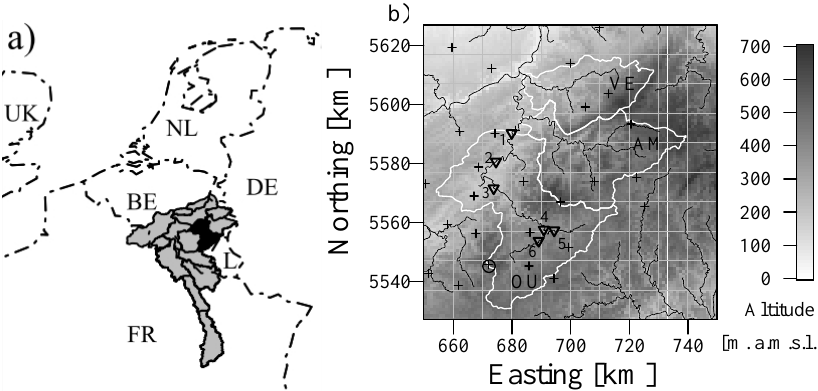
Fig. 1. (a) The Meuse River basin upstream of Sint Pieter, the entrance point into the Netherlands, and its 15 sub-catchments (grey polygons) including the Upper Ourthe (black polygon). (b) Topographic map of the Upper Ourthe (OU, white line) including the river network (black lines), rain gauges (plusses), six river gauges (triangles and labelled with numbers: 1 = Tabreux, 2 = Durbuy, 3 = Hotton, 4 = Nisramont, 5 = Mabompre, 6 = Ortho) and the climatological station in Saint Hubert (circle). For completeness, two neighbouring sub-catchments Ambleve (AM) and Vesdre (VE) are shown, however, they were not analysed in this study. The grey grid shows the 10km × 10km pixel resolution of the rainfall generator, which will be further explained in Section 2.2. Projection is in the Universal Transverse Mercator (UTM) 31N coordinate system. After Hazenberg et al. (2011).